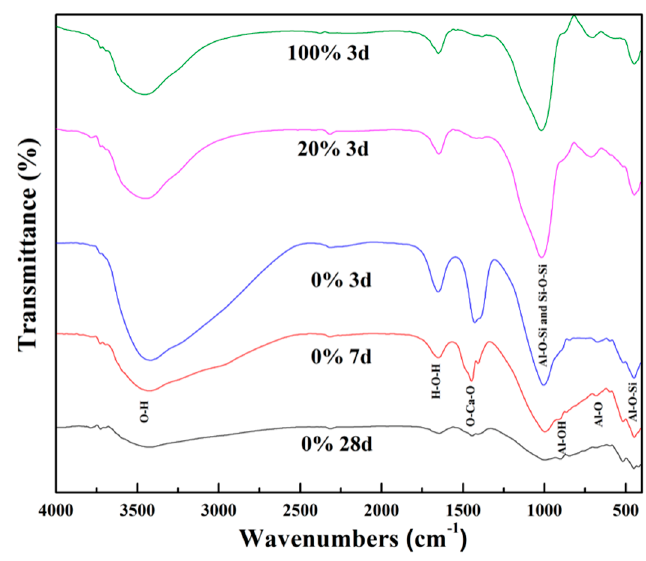
Figure 7. The FTIR spectra of the GTGs-0, GTGs-2 and GTGs-4.